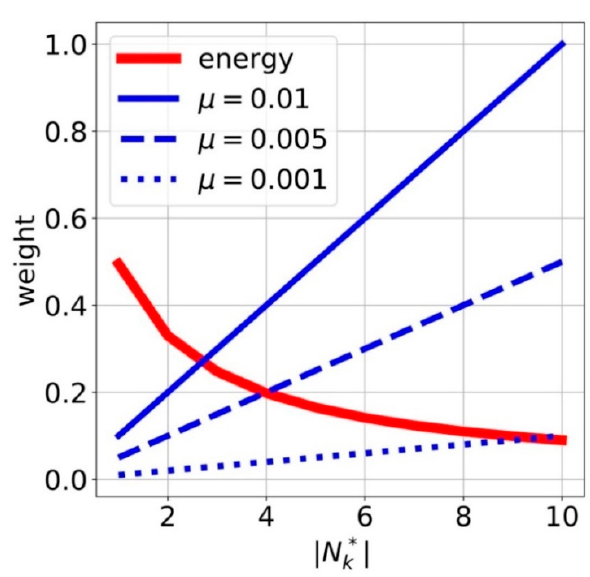
Electronics 2021 , 10 , x FOR PEER REVIEW Figure 3. The behavior of total weight components. Figure 3. The behavior of total weight components.